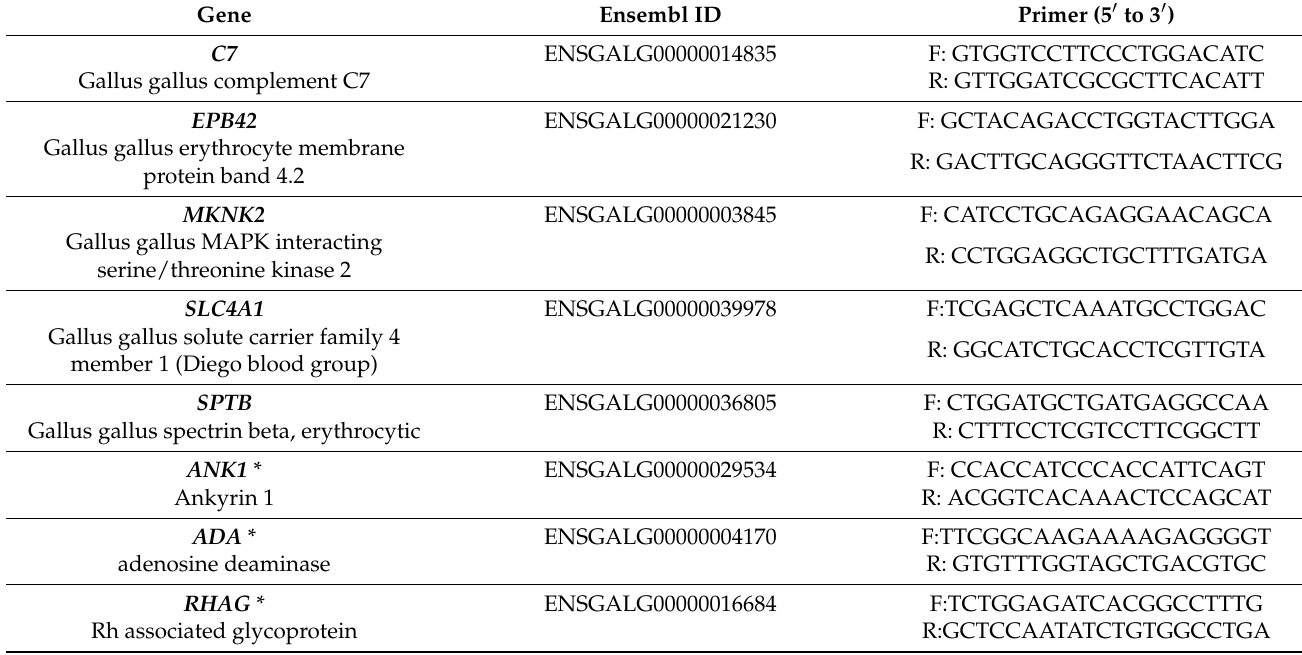
Table 1. Primers used in the qPCR analysis of articular cartilage and growth plate of normal and FHS-affected